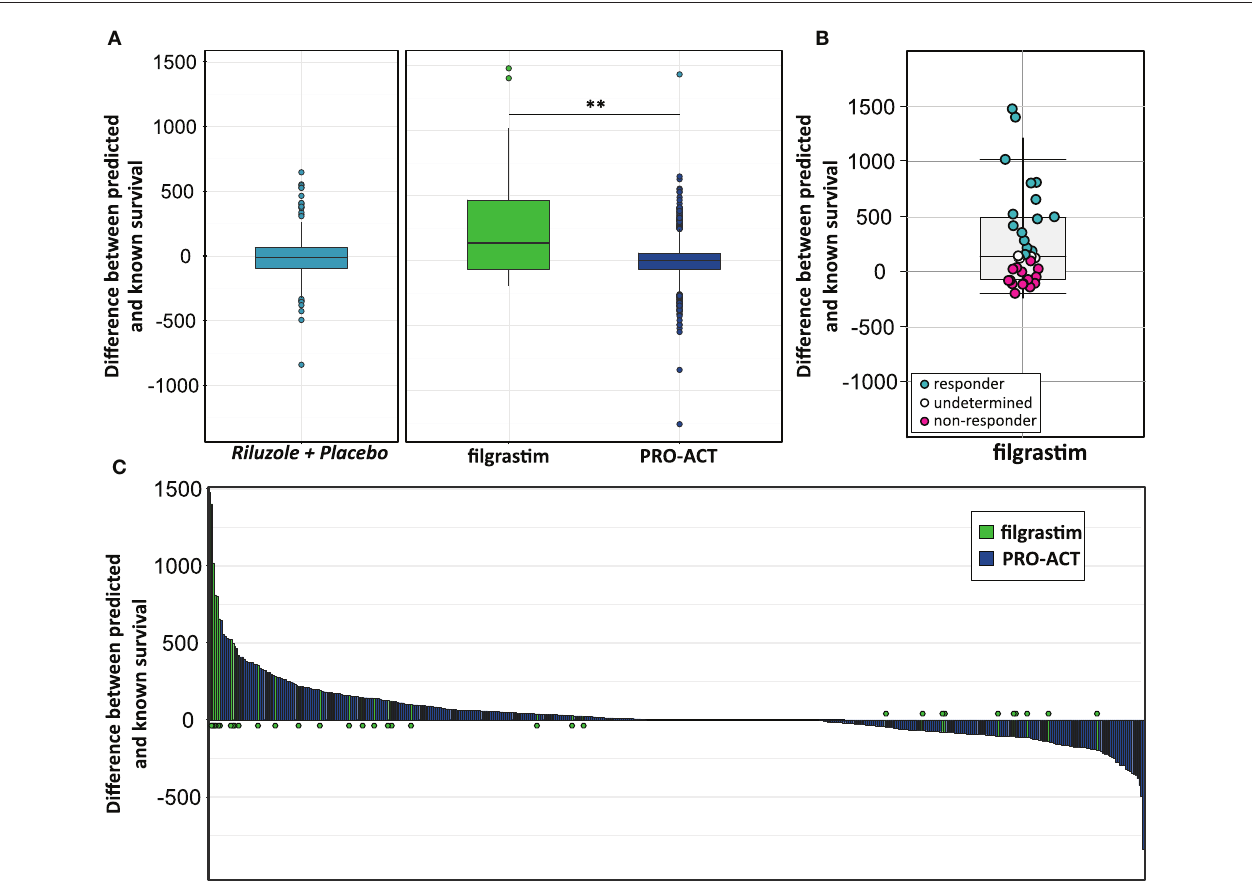
FIGURE 3 | Modeling for survival estimation. (A) Model for survival estimation. A general linear model for individual patient survival prediction based on patient variables (calculated ALSFRS-R slope, age, and treatment latency) was built in 447 deceased rp-PRO-ACT subgroup patients. The resulting model-predicted patient survival correlated with the observed survival within this subgroup ( p < 0.0001; first, turquoise graph). This observation remained identical when applying the model to all PRO-ACT patients (blue graph). The observed survival in filgrastim patients (green graph) was significantly longer than in all PRO-ACT patients and in rp-PRO-ACT subgroup ( p < 0.001, Wilcoxon test). (B) Difference between observed and model-predicted survival. The differences between observed and model-predicted survival in individual filgrastim patients are given by individual dots. Turquoise dots: responders ( n = 15); pink dots: non-responder ( n = 15); white dots: non-assignable patients ( n = 6). (C) Waterfall plot for difference between observed to model-predicted survival. Waterfall plot illustration of the difference between observed and model-predicted survival in filgrastim patients (green lines, N = 36) and PRO-ACT patients (blue lines, N = 6,927), where positive values indicate longer than predicted individual survival. ** p <